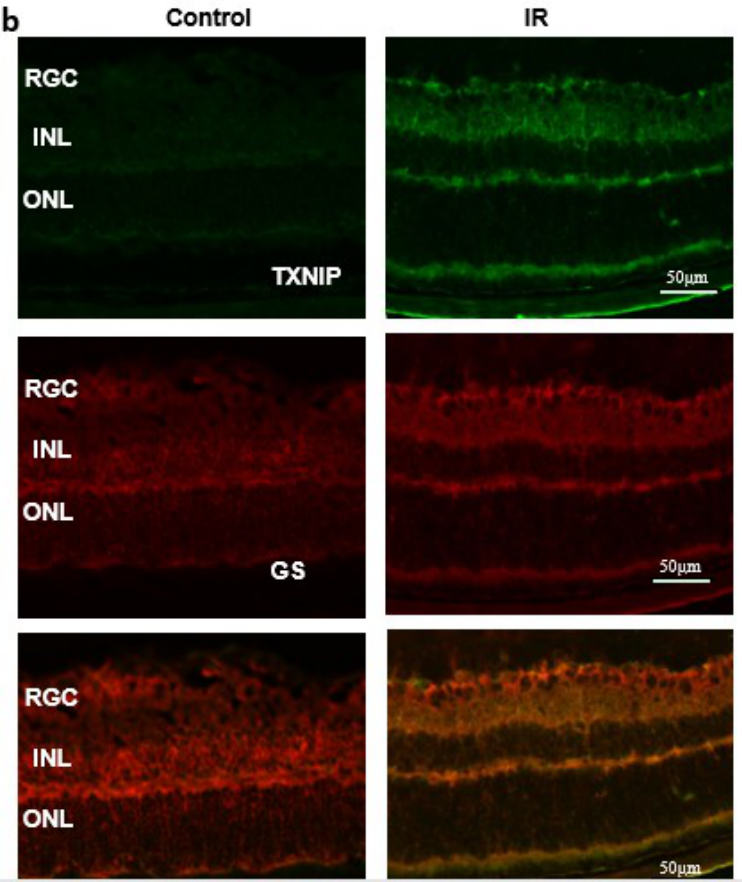
Figure 2. ( a ) Ischemia/Reperfusion (IR) induced strong activation of Muller cells, the main glia in the retina, assessed by GFAP radial staining after 3-days and persisted for 14-days after ischemia. ( b ) Immunostaining studies using anti-TXNIP (green), anti-glutamine synthetase (GS, red) showed prominent colocalization (yellow) of TXNIP within Muller cells in response to IR when compared to shams.